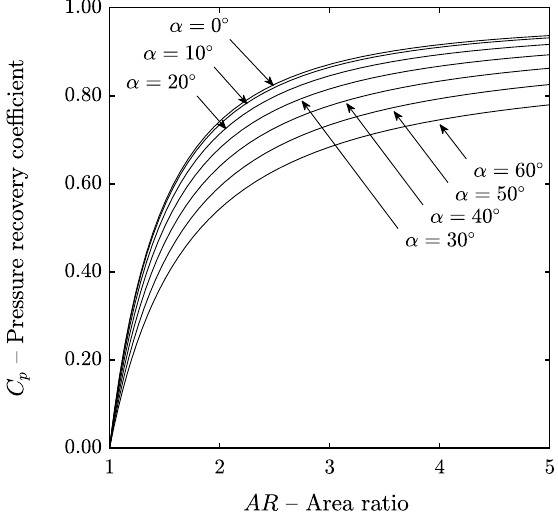
Figure 11. Influence of the inlet swirl